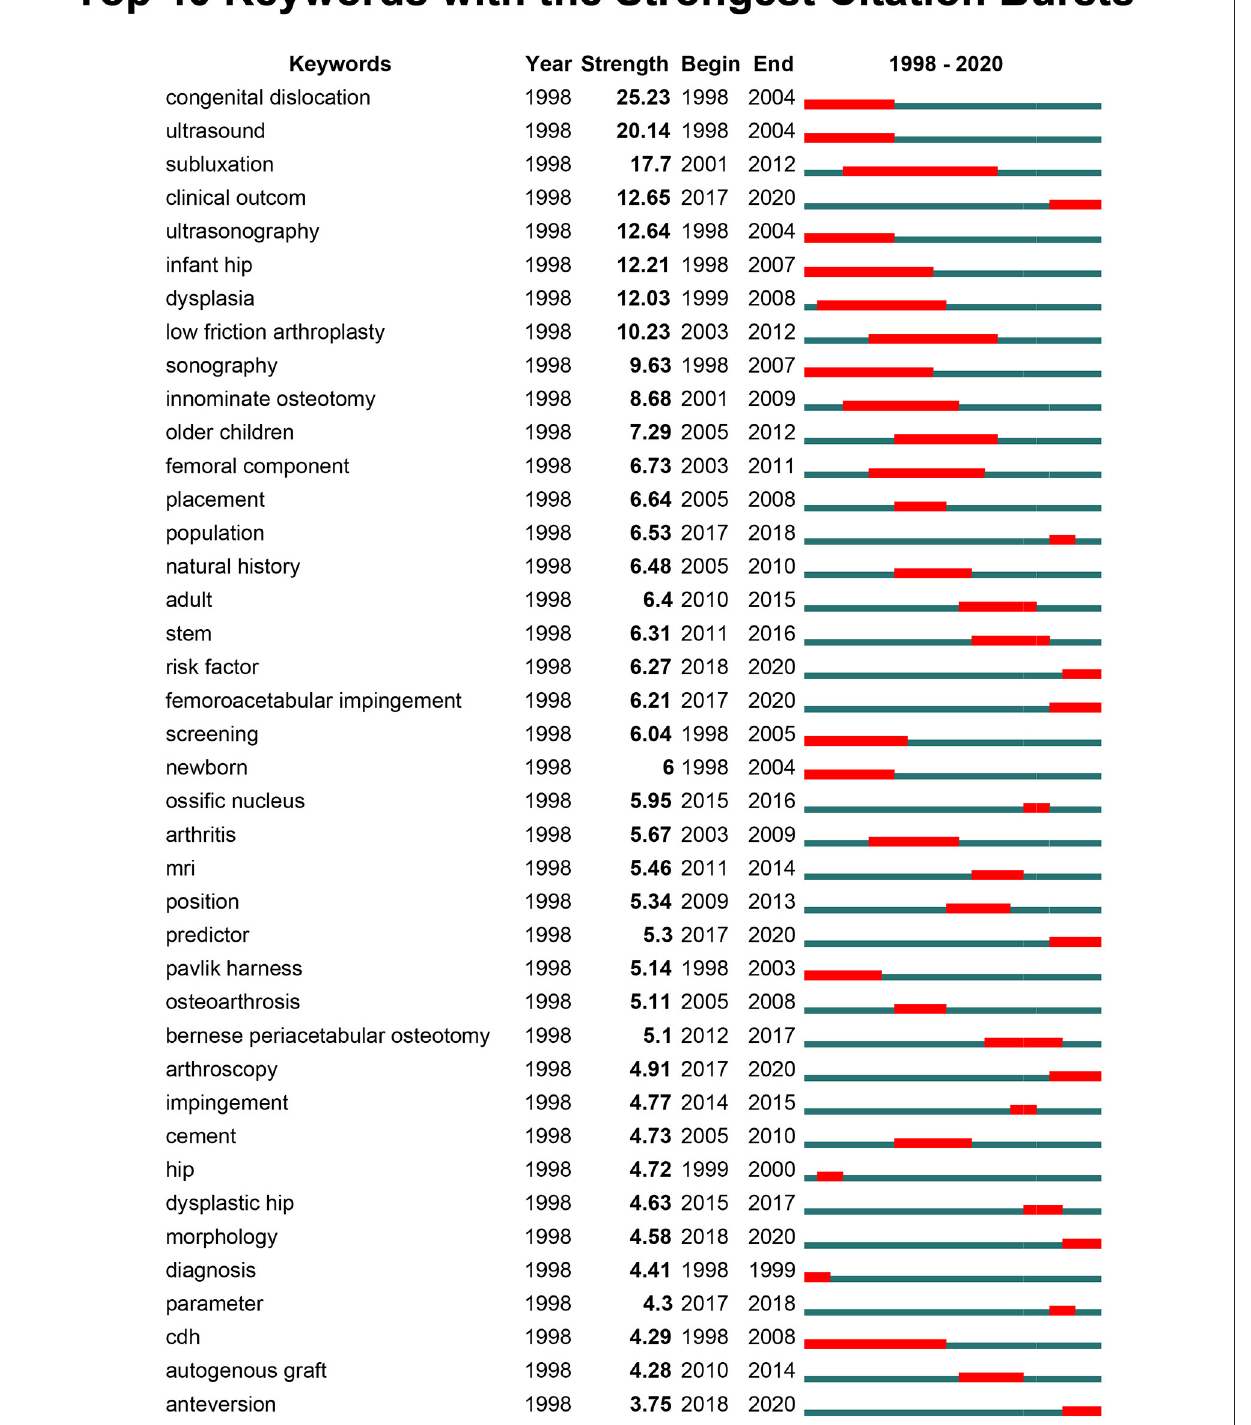
Frontiers in Surgery |